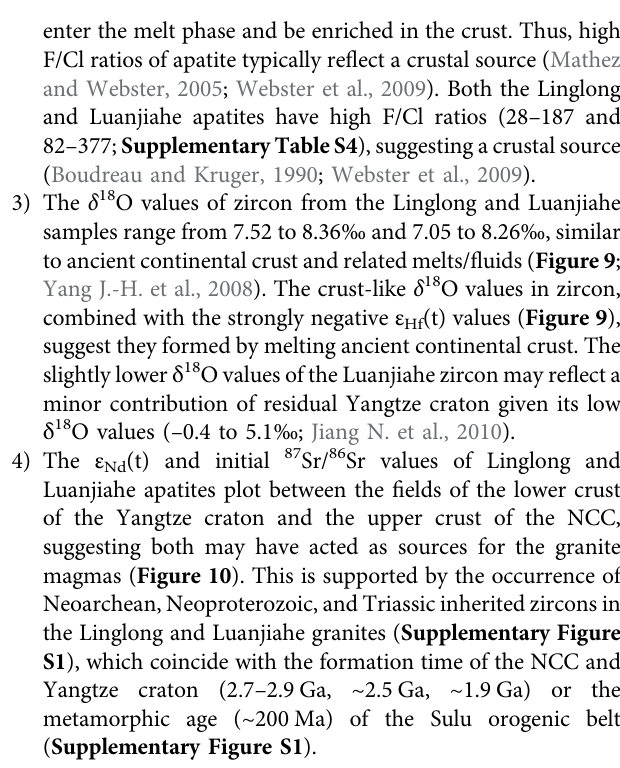
Frontiers in Earth Science |